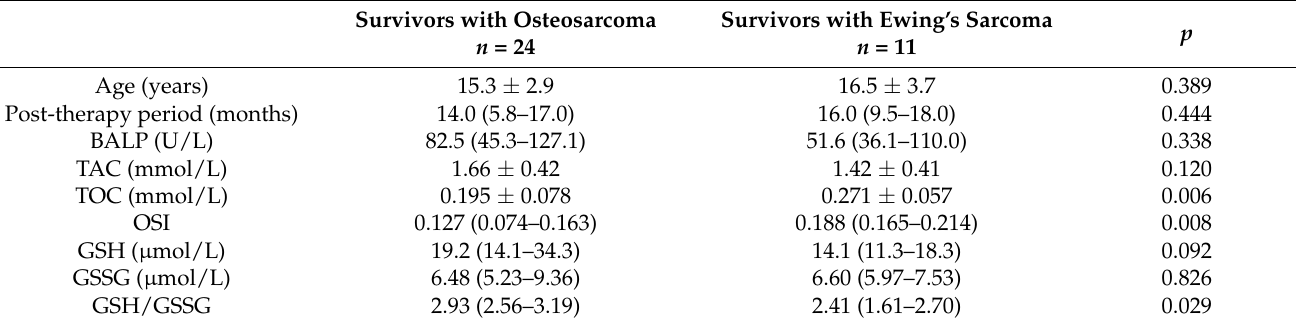
Table 3. Differences in biochemical parameters between survivors with osteosarcoma and Ewing’s